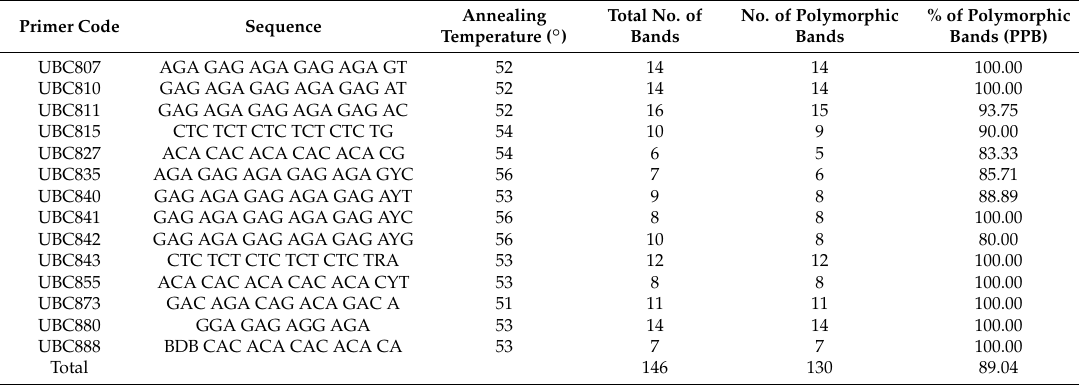
Table 2. Total number of bands, number and percentage of polymorphic bands generated by 14 ISSR primers from 33 plum